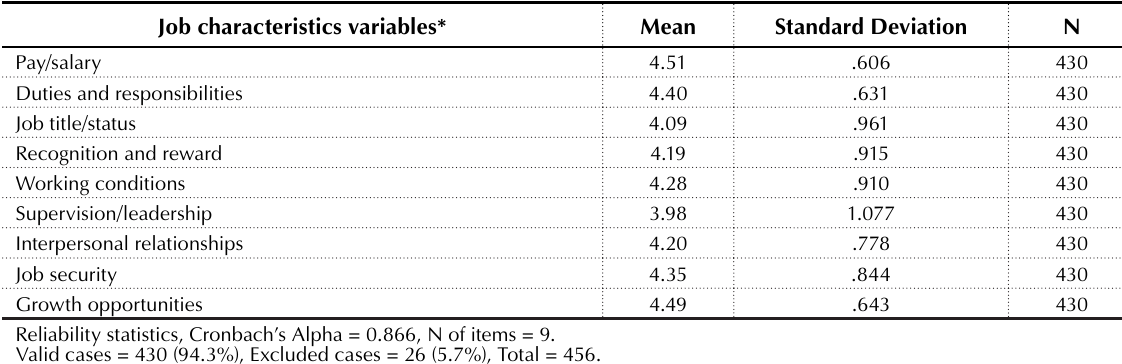
Table 3. Reliability test: importance of job characteristics’ variables to work motivation (n = 456) Job characteristics variables*